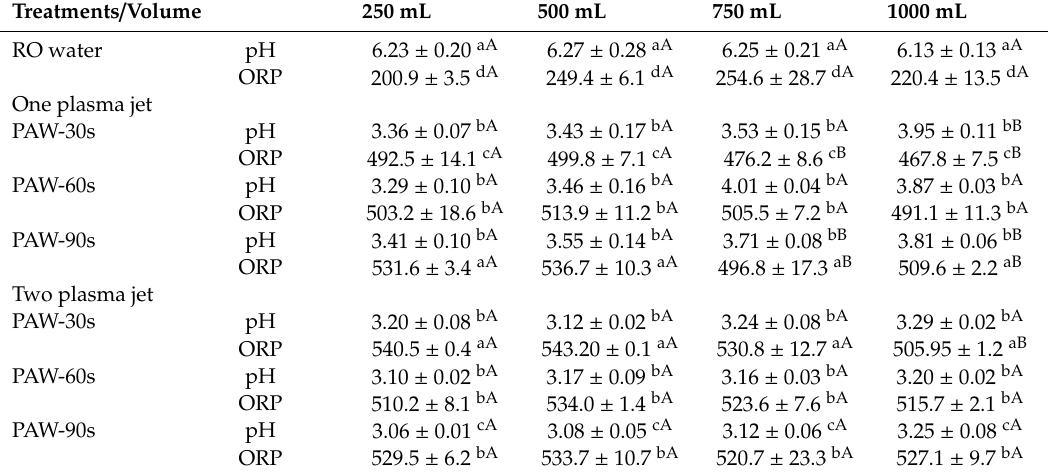
Table 4. The pH and oxidative-reduction potential (ORP) values of the plasma-activated water (PAW) generated with one plasma jet and two plasma jets at various treatment times and water volumes.